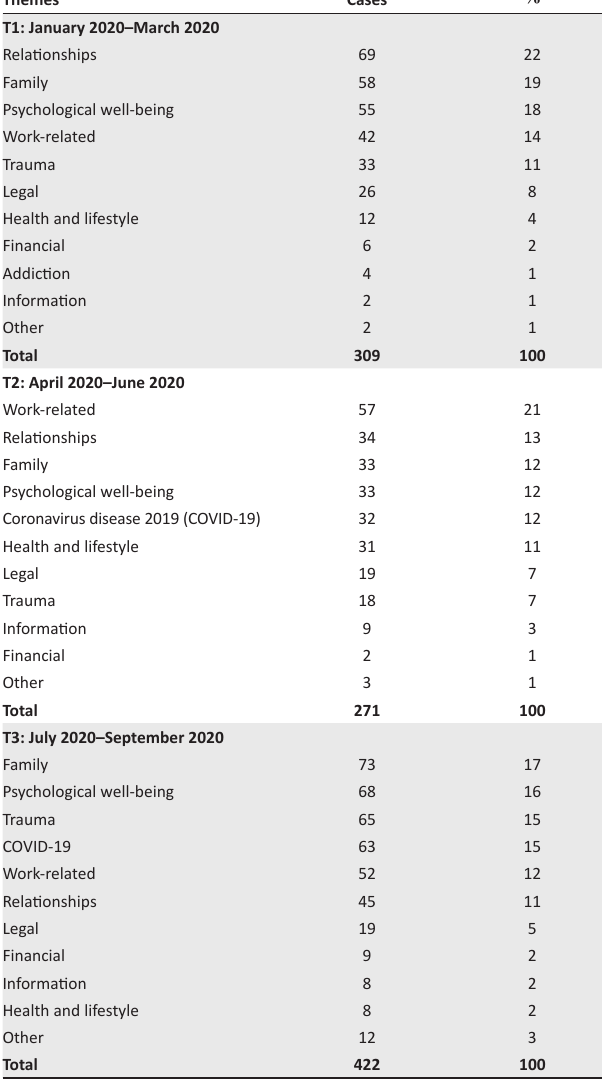
TABLE 4: Frequency of themes per period.